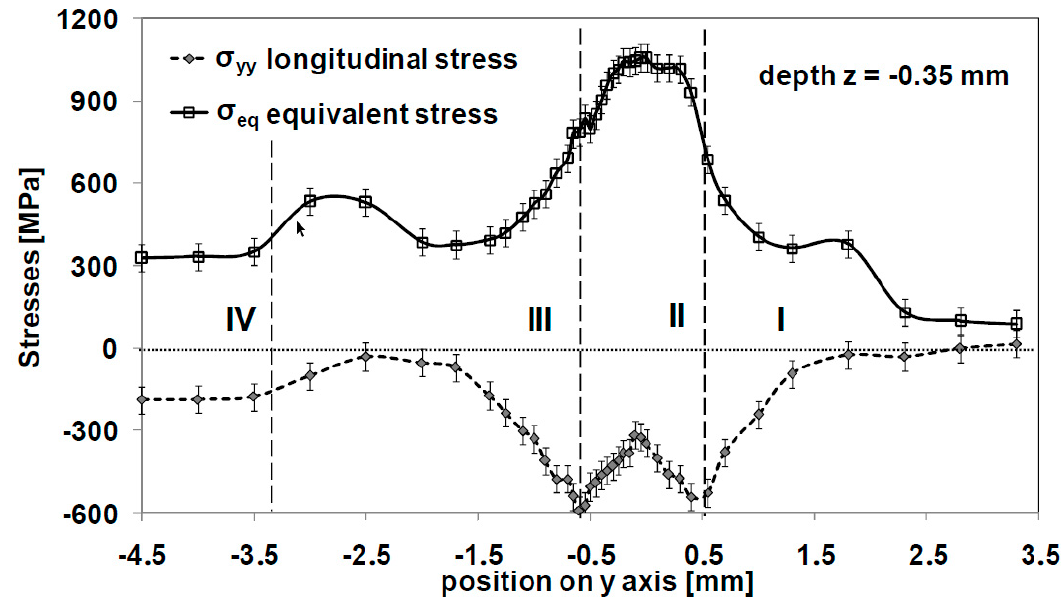
Figure 8. Plot of longitudinal ( σ yy ) and equivalent stress ( σ eq ) evolutions for the material state at the depth of maximum residual stress in the σ yy direction at z = − 0.35 mm for 3900 N load.